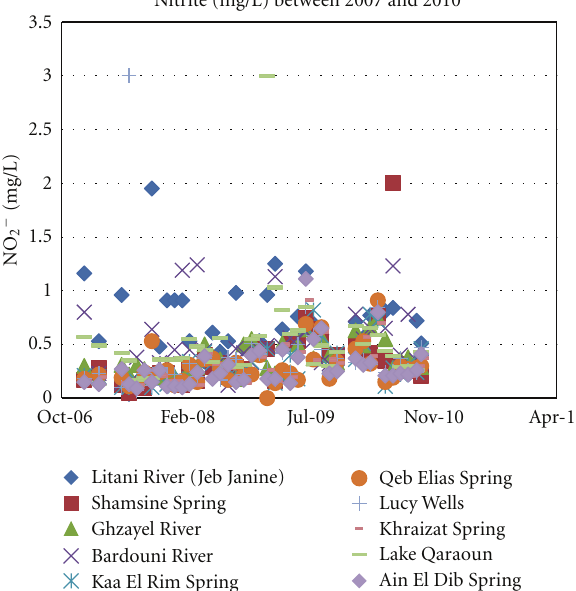
Figure 11: Phosphate concentrations for years 2007 through